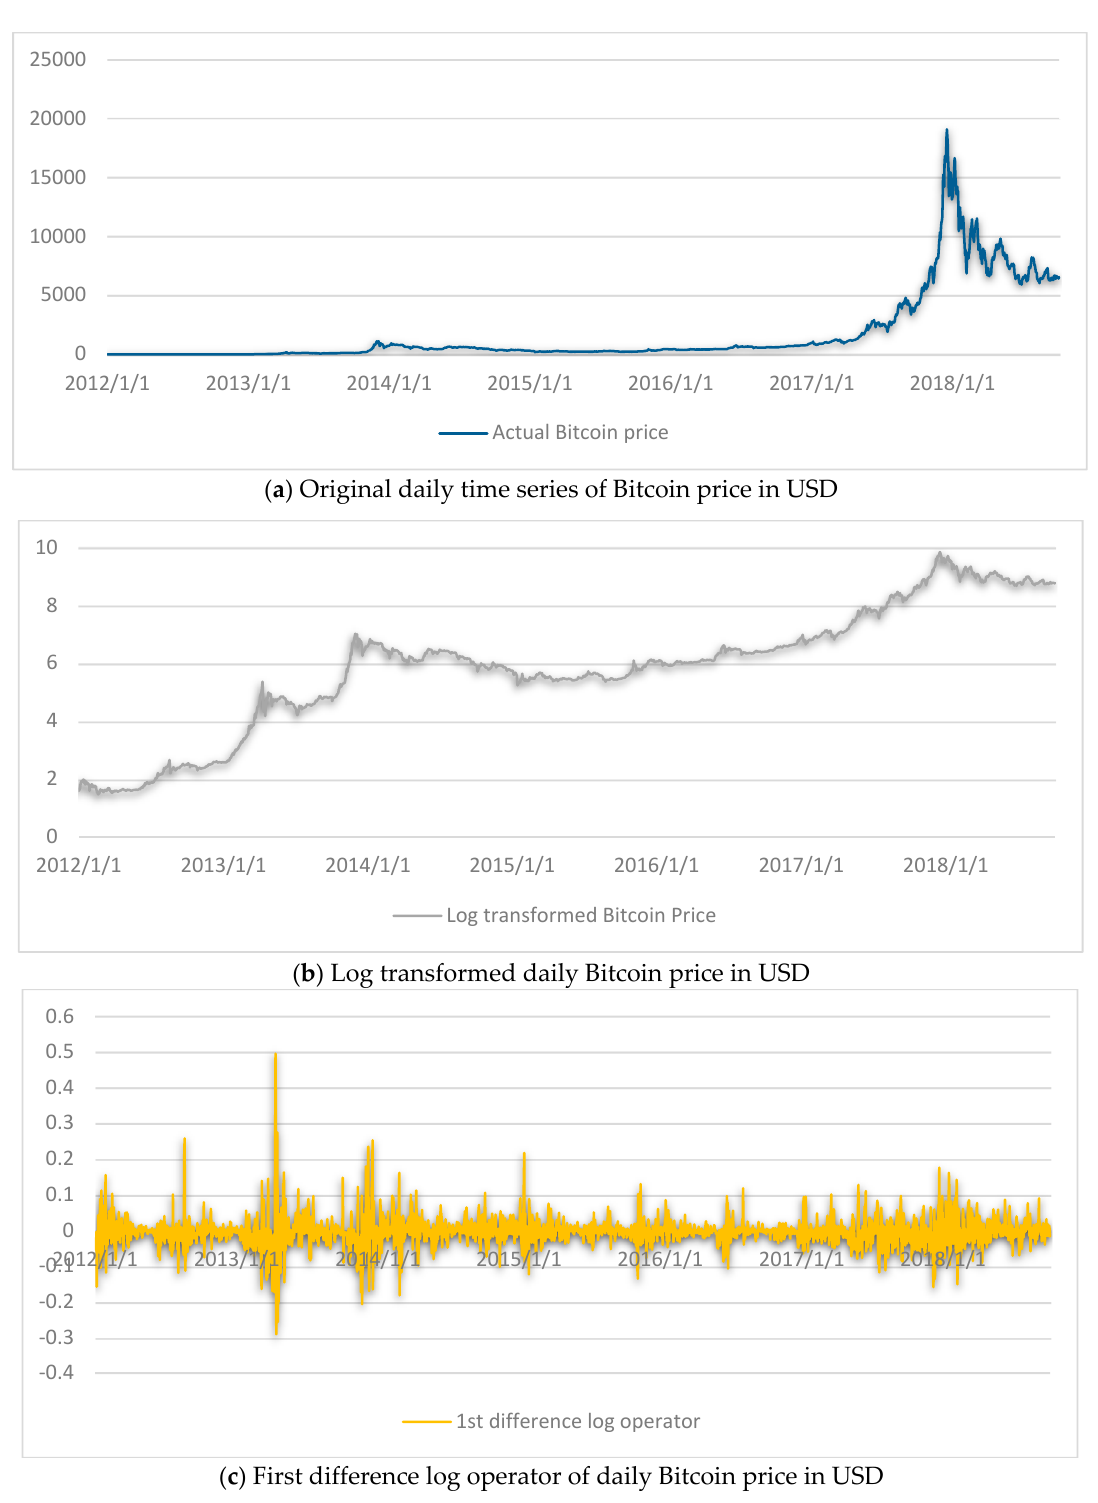
Figure 1. ( a ) Original, ( b ) log-transformed and ( c ) first difference log operator bitcoin price in USD.